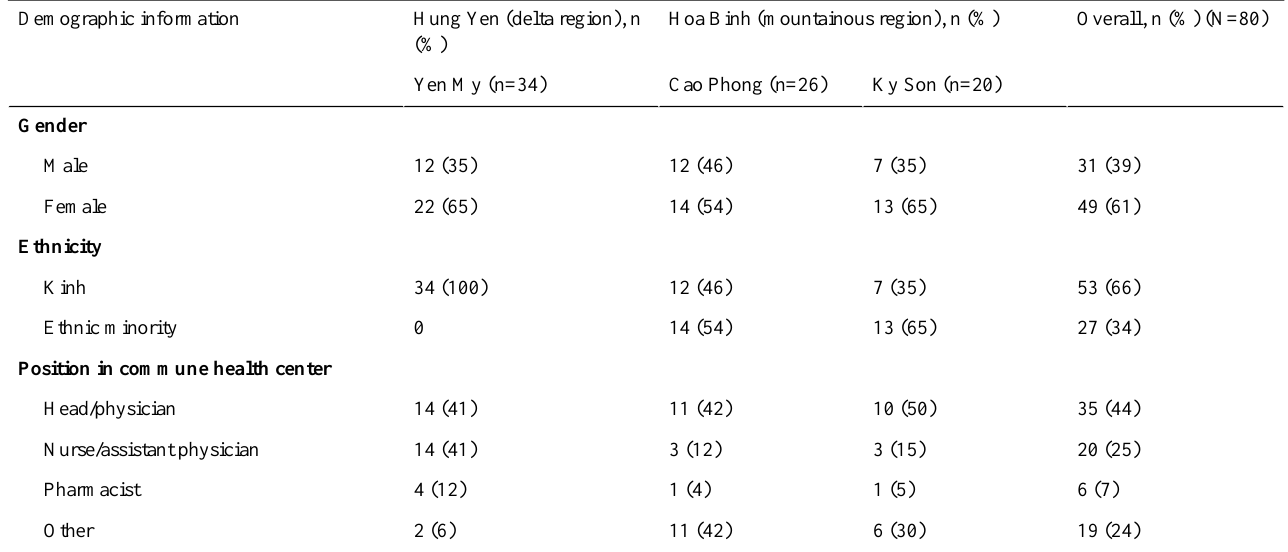
Table 1. Demographic information of participants.